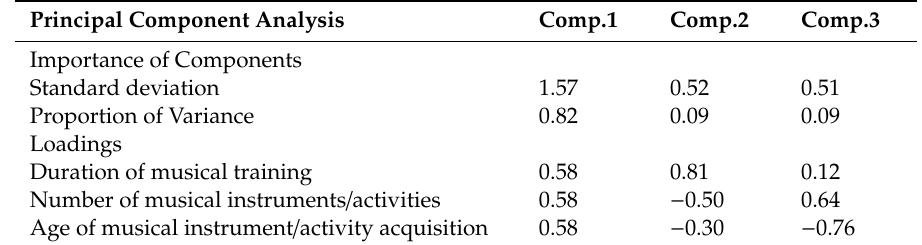
Table A2. Results of the Principal Component Analysis over the data of three variables relating to general musical